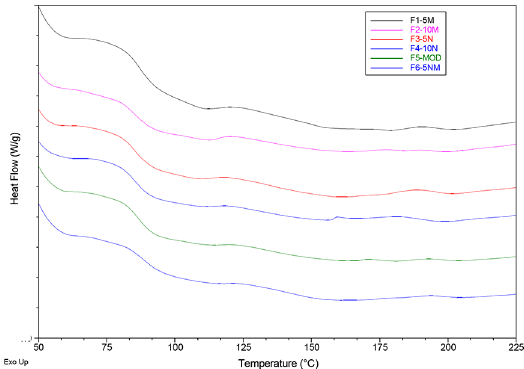
Figure 7 . DSC curves for the PVC formulations with micro and nano-CaCO . 3